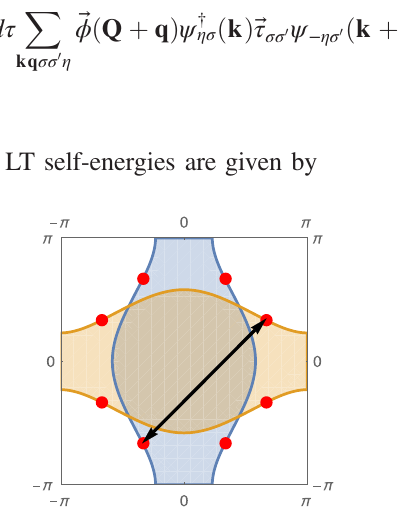
FIG. 4. FS structure of the two-band spin-fermion model used in the QMC simulations and the LT calculations. Hotspots are indicated in red and are connected by the AF wave vector Q ¼ ð π ; π Þ , denoted by an